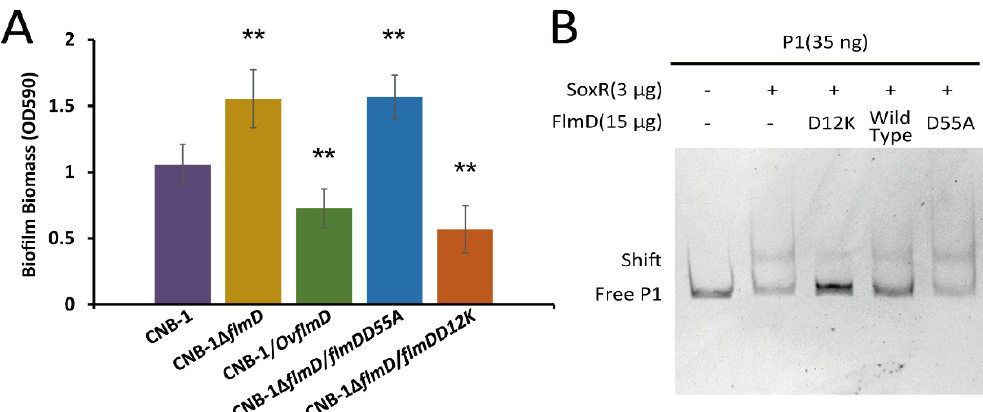
Figure 4. The phosphorylation of FlmD is essential for negative regulation. ( A ) Functional characterization of biofilm formation in flmD mutants assessed using crystal violet assay. ( B ) Changes in the interaction between SoxR and the acrAB-tolC operon on the addition of FlmD variants to gel shift assay systems are shown. Data in panel A are the means and standard deviations from three independent experiments conducted in triplicate. (** p < 0.01 with Student’s t -test or rank sum test.).